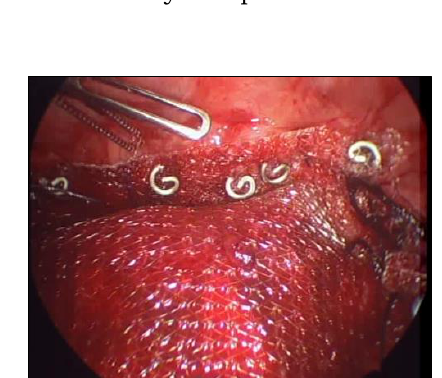
Figure 1: Thoracoscopic spiral tack application